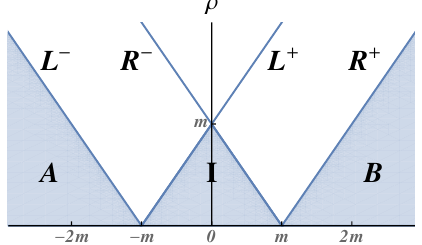
Figure 3. Regions in the Weyl upper-half plane for which both (cid:28) 1 and (cid:28) 2 are real.